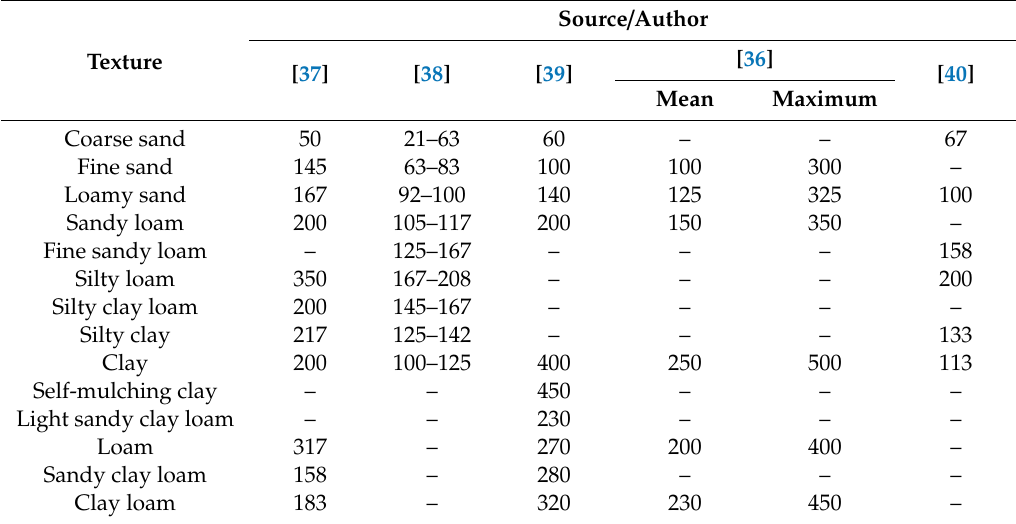
Table 1. Review of water-holding capacity (mm · m − 3 ) of main soil texture